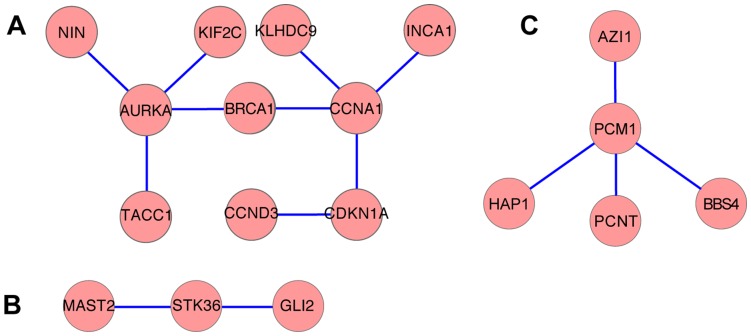
Functional mapping of candidate centrosome/cilia proteins and identification of novel centrosome components.Candidate genes were organized by known physical and genetic interactions mined from Mitocheck, the Human Protein Reference Database and BioGrid. Clusters containing genes associated with cell cycle control (A), hedgehog signaling (B) and the PCM1 complex (C) are shown.